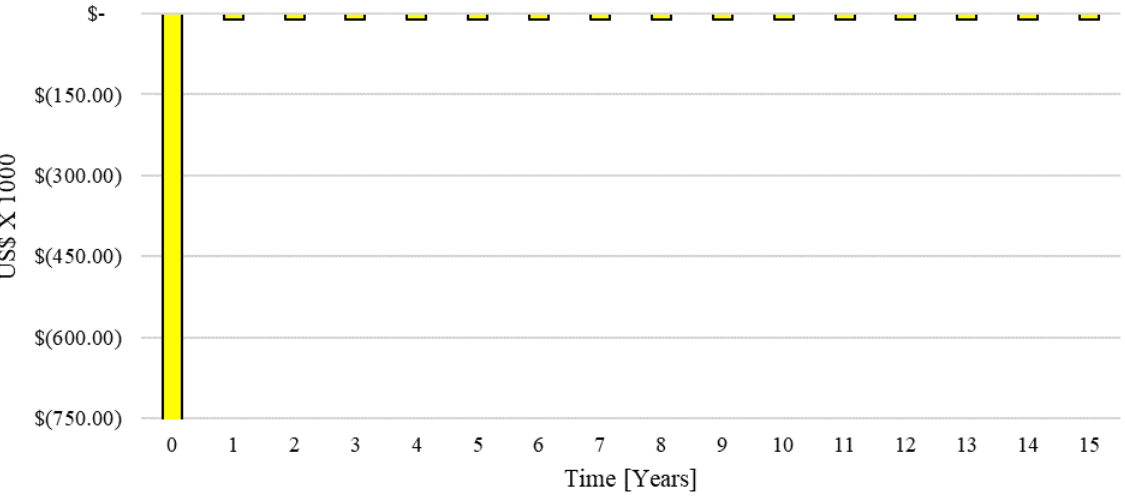
Figure 12. Cash flow from the gas microturbine and downdraft gasifier-based generation system using oxygen-enriched air as a gasification agent.